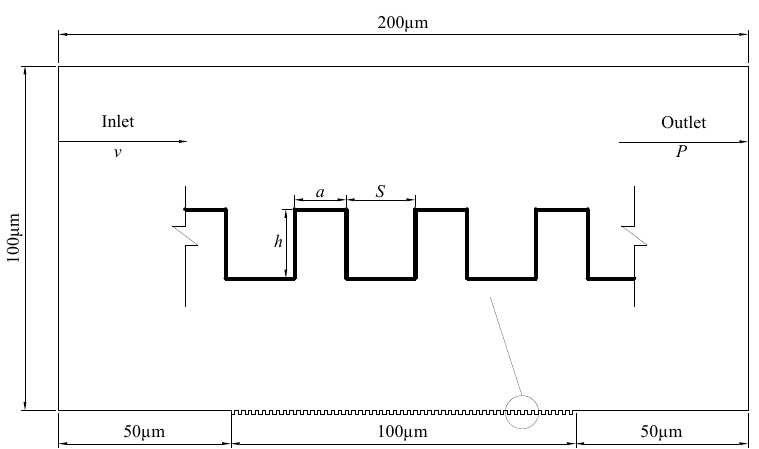
Figure 1. The model calculation area.